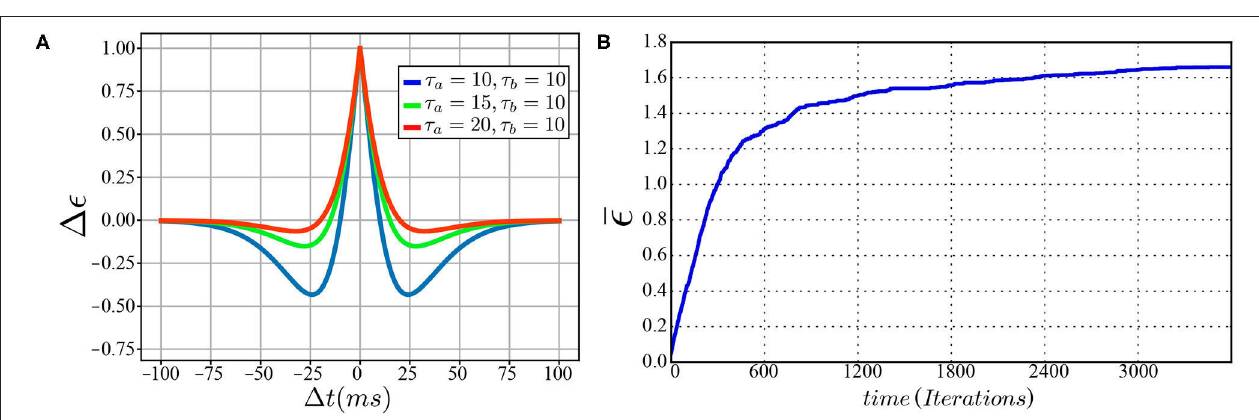
FIGURE 2 | Schematic diagrams for motor cortex-like map